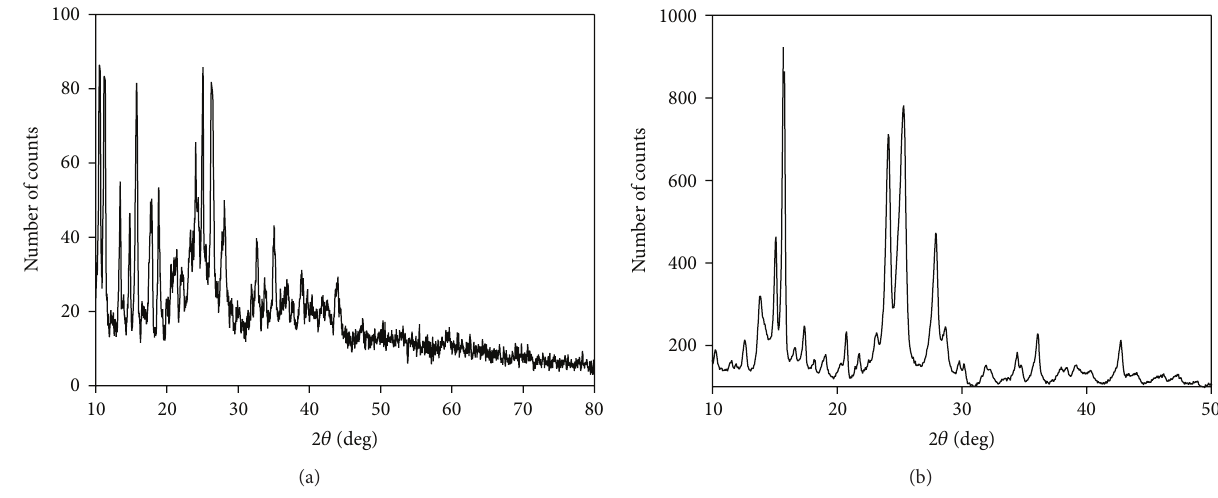
Figure 5: Powder XRD patterns of (a) [Ni(L 1 ) 2 ] (b) [Zn(L 1 ) 2 ] ⋅ H 2 O.